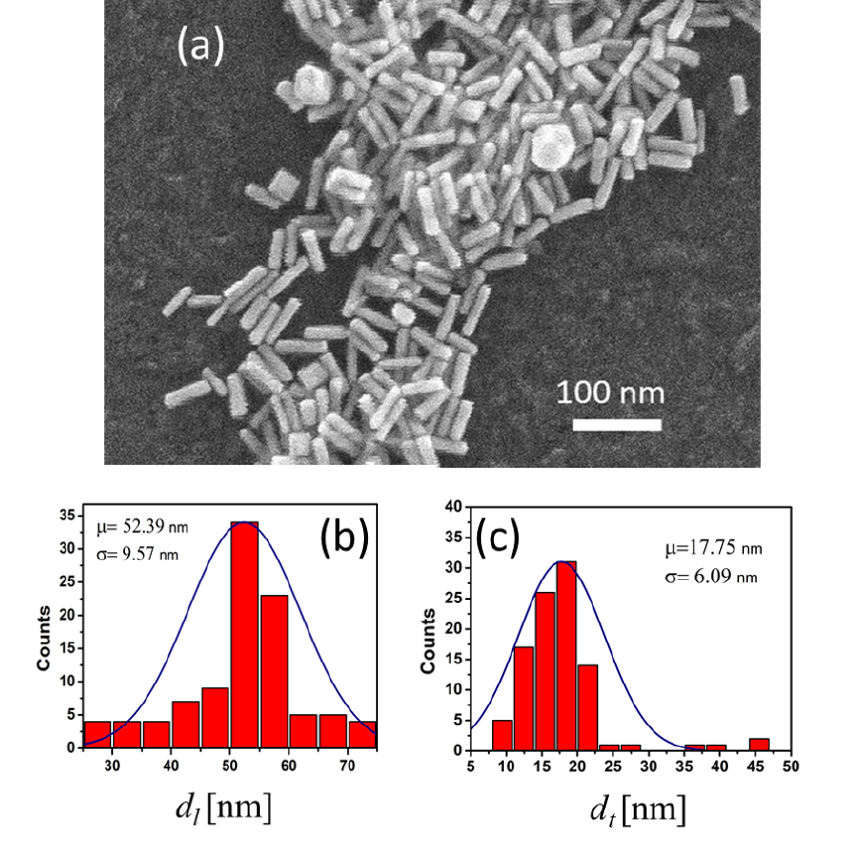
Figure 1. ( a ) SEM image of some of the gold nanorods synthesized. We plotted the histograms of the values of the major axis ( b ) and minor axis ( c ) of the fabricated nanoparticles. The solid line represents the Gaussian fitting where µ and σ are the mean and standard deviation of these distributions,